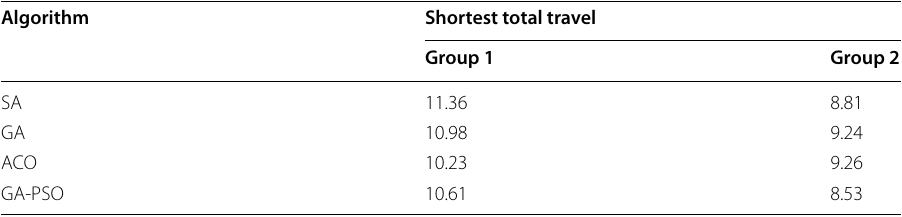
Table 7 The shortest total travel distances of the four algorithms in the two groups of experiments